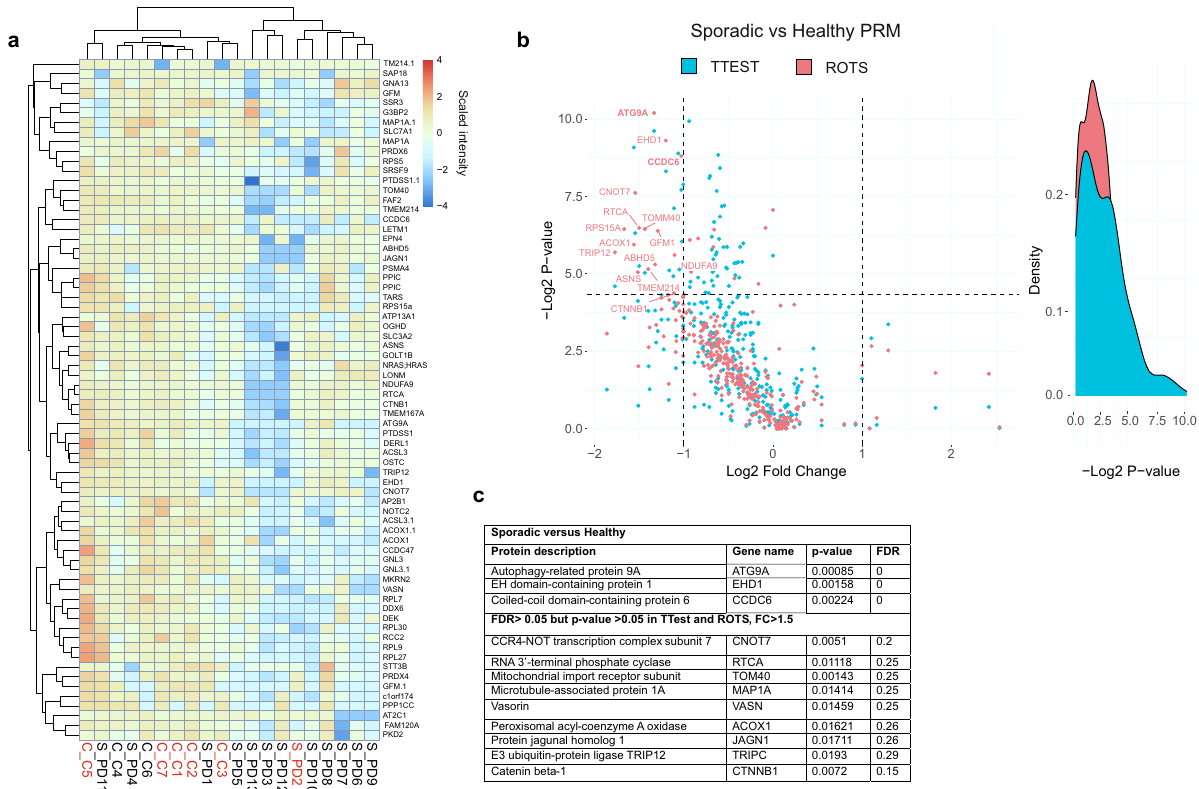
Fig. 4 PRM validation of protein homeostasis changes in sporadic Parkinson ’ s patient cells. Targeted proteomics (PRM quanti fi cation of peptides from Fig. 2c), was carried out to validate protein intensity differences from total lysates of patient cells. a Hierarchical clustering of PRM results shows overall protein intensities in fi broblasts from sporadic and healthy controls with a p -value < 0.05 in either ROTS and/or t - test. b Volcano plot of PRM results from sporadic vs healthy. P -values from ROTS and t -test statistical tests are shown. Red sample label indicates female gender. c The top changing proteins are